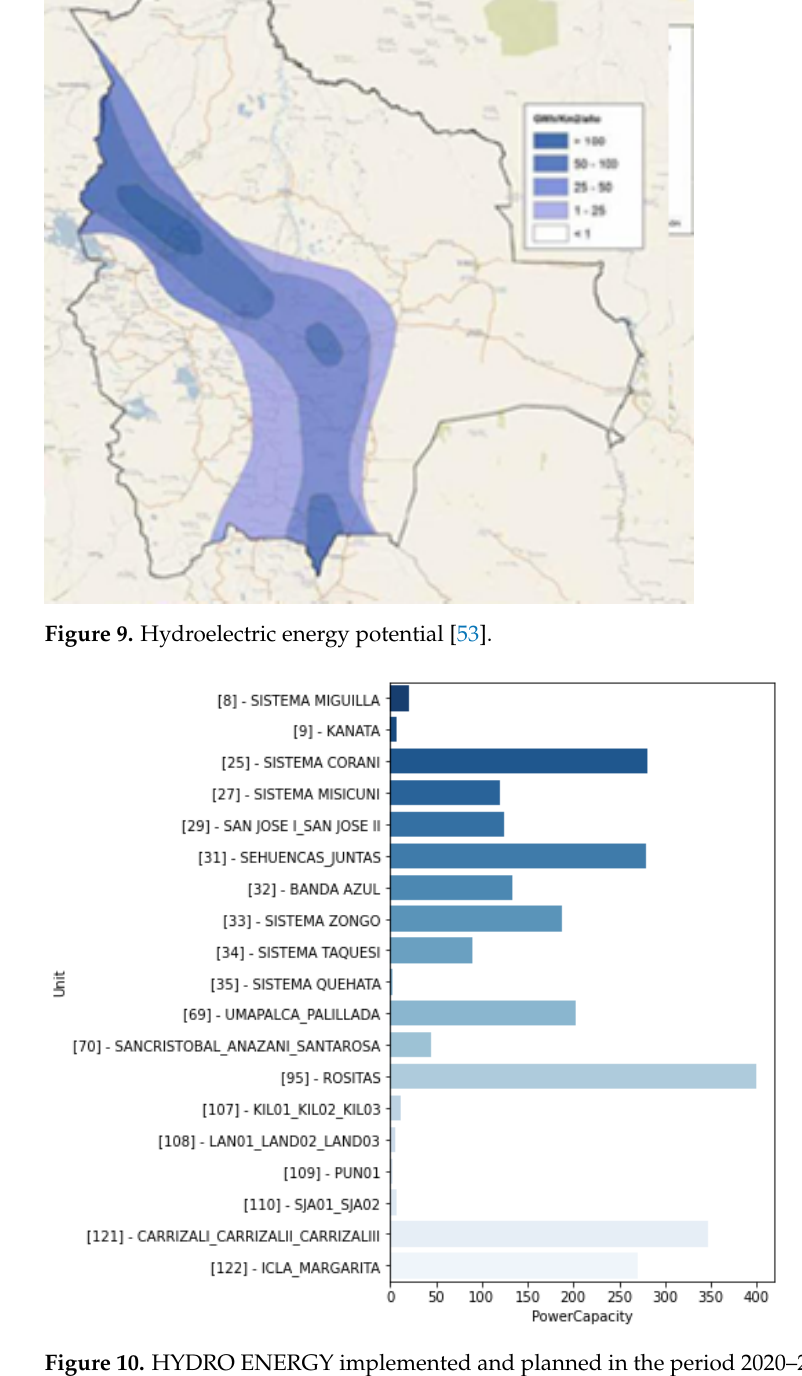
Figure 10. HYDRO ENERGY implemented and planned in the period 2020–2025 [35]. Availability factors for hydro run-of-river resources are derived from interpolating av- erage weekly flows obtained from [46]. Unit technical data such as turbine type, efficiency, nominal power and height of fall were gathered from [54]. Every run-of-river unit is as- signed with its own availability factor distribution expressed in time series (e.g., Figure